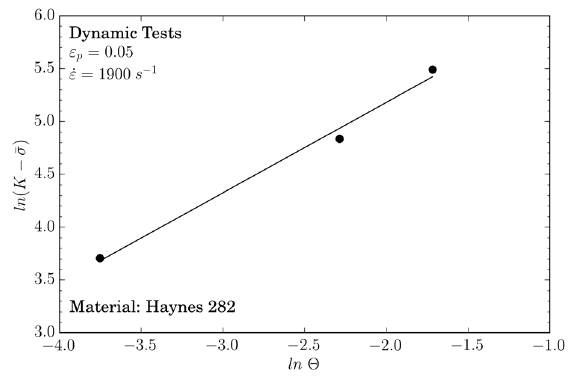
Figure 7. ln(cid:4666)(cid:1837) (cid:3398) (cid:2026)(cid:3364)(cid:4667) (cid:3398) ln(cid:4666)(cid:1990)(cid:4667) curve and linear fitting to obtain (cid:1865) . Figure 7. ln ( K − ¯ σ ) − ln ( Θ ) curve and linear fitting to obtain m .